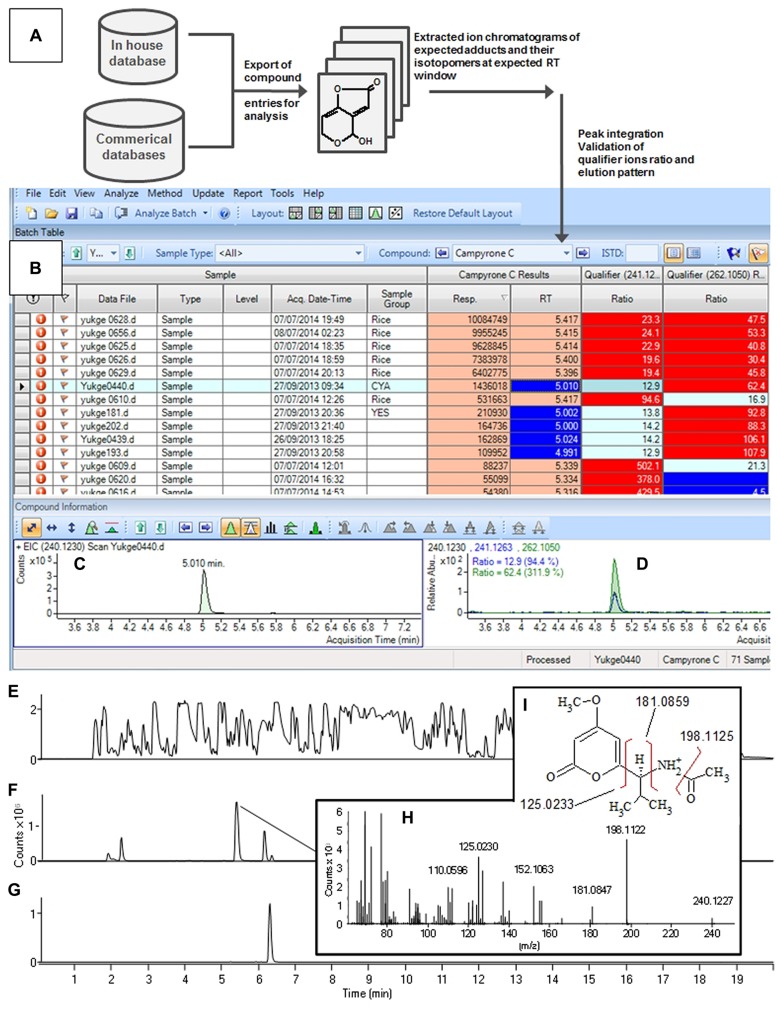
Aggressive (A–C) batch processing of 150 samples (12 shown), here sorted by peak area (Response column) of mass of [M+H]+ of campyrone C (240.1230 ± 20 ppm) shown in (C). While (D) shows the overlaid extracted ion chromatograms of the same as well as 13C112C12 [M+H]+ isotopomer and the [M+Na]+ ion. (F–I) Manual verification of data file with highest peak intensity of campyrone C. (E) Shows the highly complex Base Peak chromatogram, while, the extracted ion chromatograms of [M+H]+ of campyrone C and A/B respectively. (G) Shows the MS/MS spectrum at 10 eV of the tentatively identified campyrone C with (H) Showing the structure of campyrone C along with (I) theoretical masses of 3 likely fragmentation of the molecule. For instrument settings see Kildgaard et al. (2014).